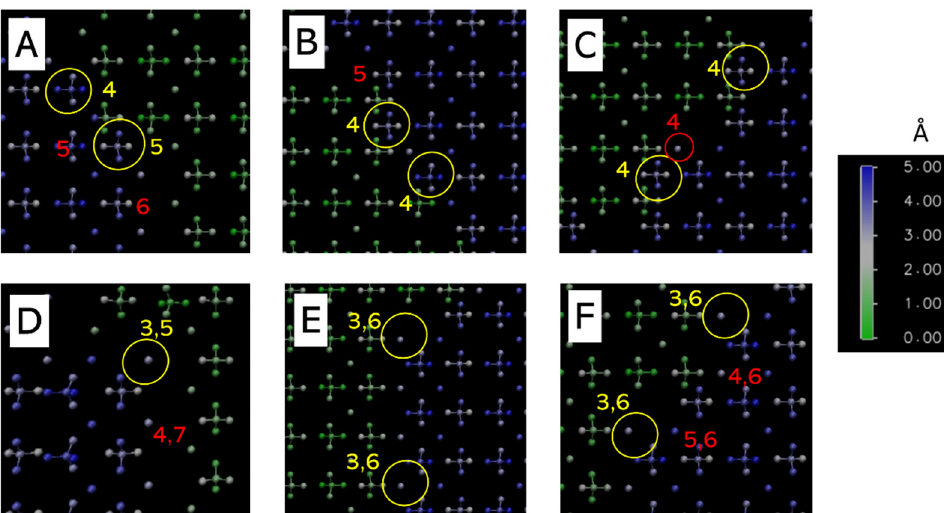
Figure 8. Coordination of kink sites on barite (001) face. Yellow numbers show coordination of kink sites. Red numbers show coordination of terrace and step sites. ( A ): SO 4 sites at the left (slow) [010] step; ( B ): SO 4 sites at the right “fast” [010] step; ( C ): SO 4 sites at the segmented [120] step; ( D ): Ba kink site at the left (slow) [010] step; ( E ): Ba kink sites at the right (fast) [010] step; ( F ): overhanging Ba kink sites at the [120] step.